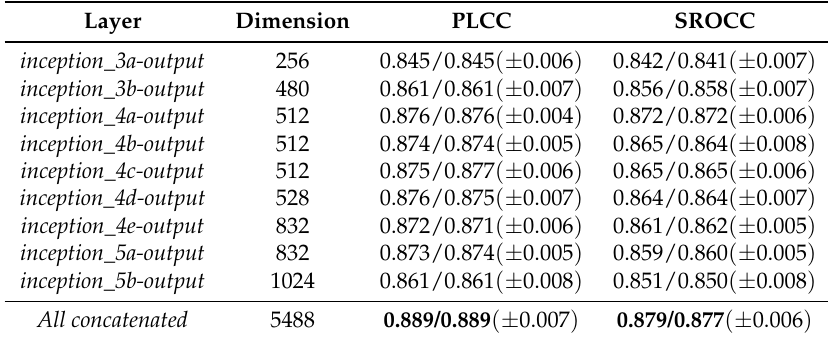
Table 1. Performance comparison of deep features extracted from GoogLeNet’s [31] Inception modules without fine-tuning measured on KonIQ-10k [33]. Average/median ( ± std ) values are reported over 20 random train-test splits. The best results are in bold .